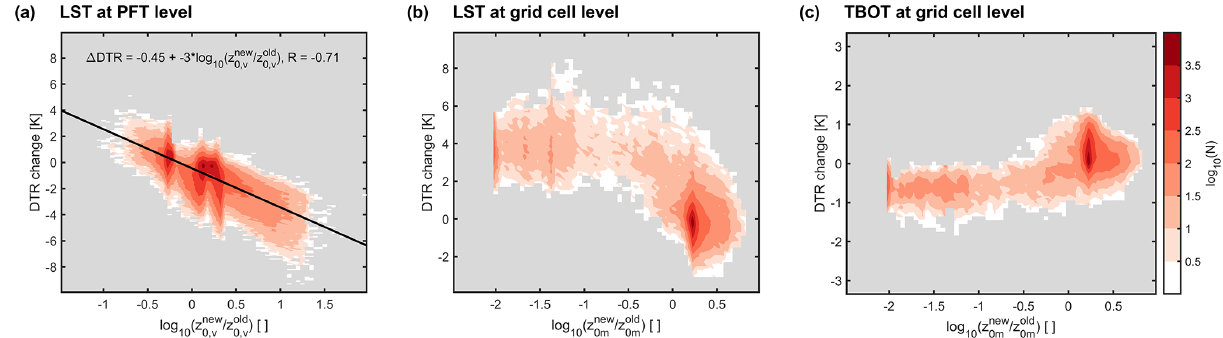
Figure 13. (a) Density plot of change in multi-year monthly mean LST DTR at the PFT level of CESM-Z0 minus CESM-CTL versus the decimal logarithm of the ratio of z 0 , v in CESM-Z0 divided by z 0 , v in CESM-CTL. Bin size on the x axis is 0.05, and on the y axis it is 0.1K. Color scale on the far right shows the decimal logarithm of the number of tiles that fall within the respective bin. Multi-year monthly mean data of all PFTs excluding bare soil between 30 ◦ N/S were used to generate this figure. (b–c) The same for the LST DTR (b) and TBOT DTR (c) at grid cell level and the maximum of z 0m , g and z 0 , v . Bin size on the y axis in panel (c) is 0.05K. The black line in panel (a) shows the linear fit with its formula and the Pearson correlation coefficient ( R ) above. Note the differing ranges of the y axis for the different